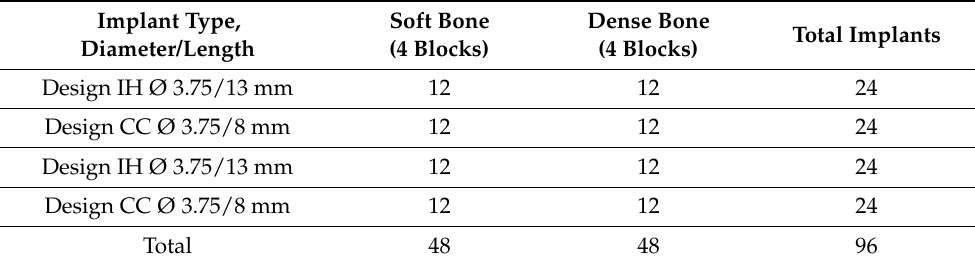
Table 1. Experimental group design and sample